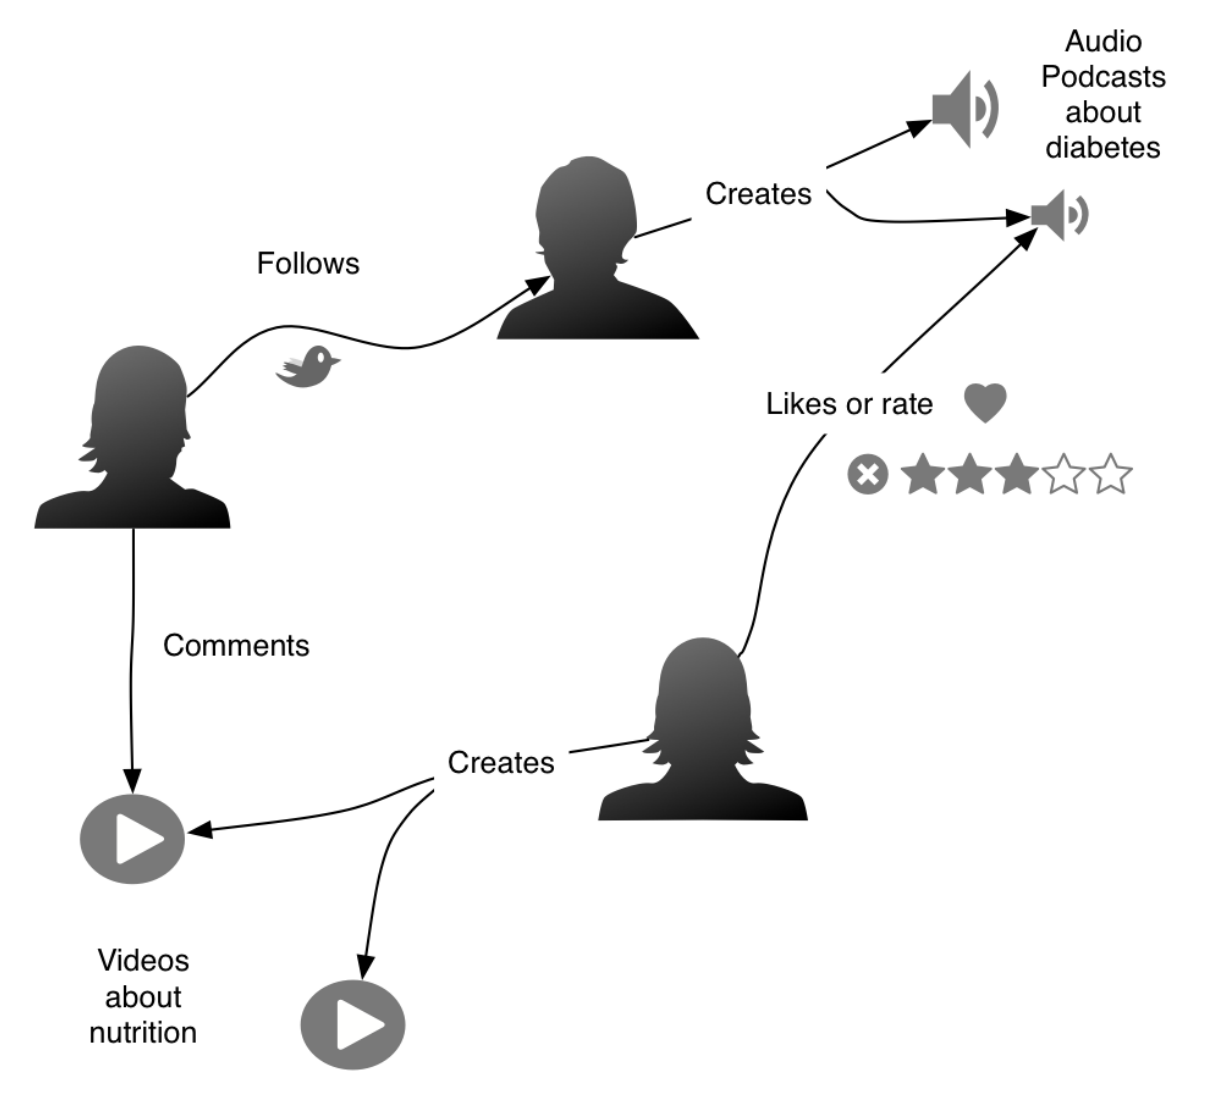
Figure 1. Example of a health social network.